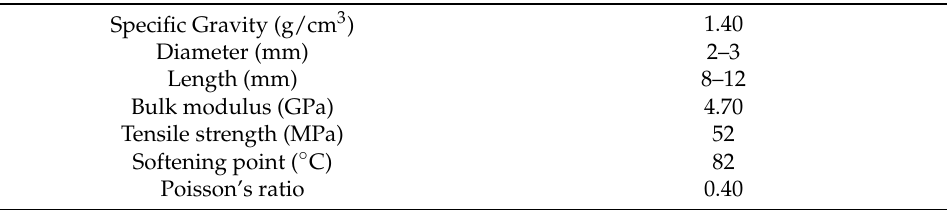
Figure 1. Particle size distribution of crushed sand aggregates. Table 1. Typical properties of